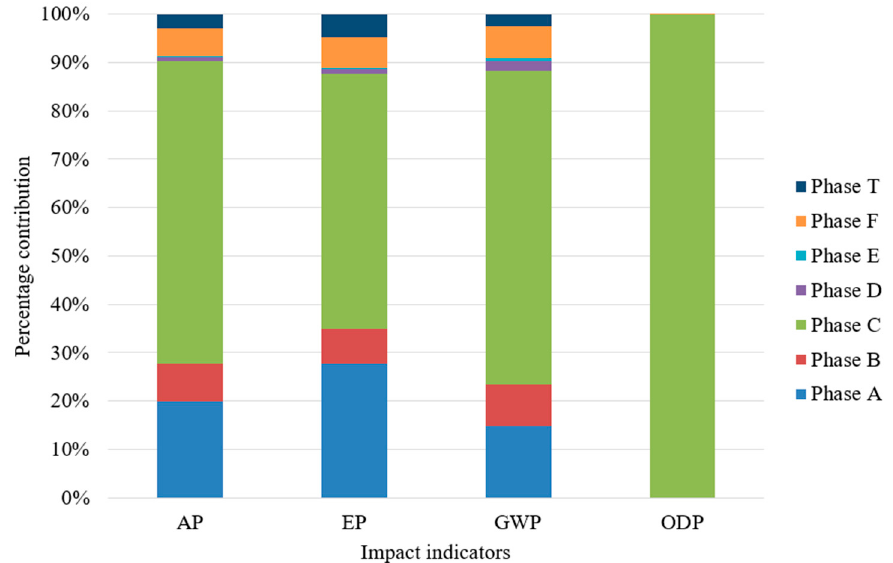
Figure 16. Percentage contribution of impact indicators on the phases of prefabricated system